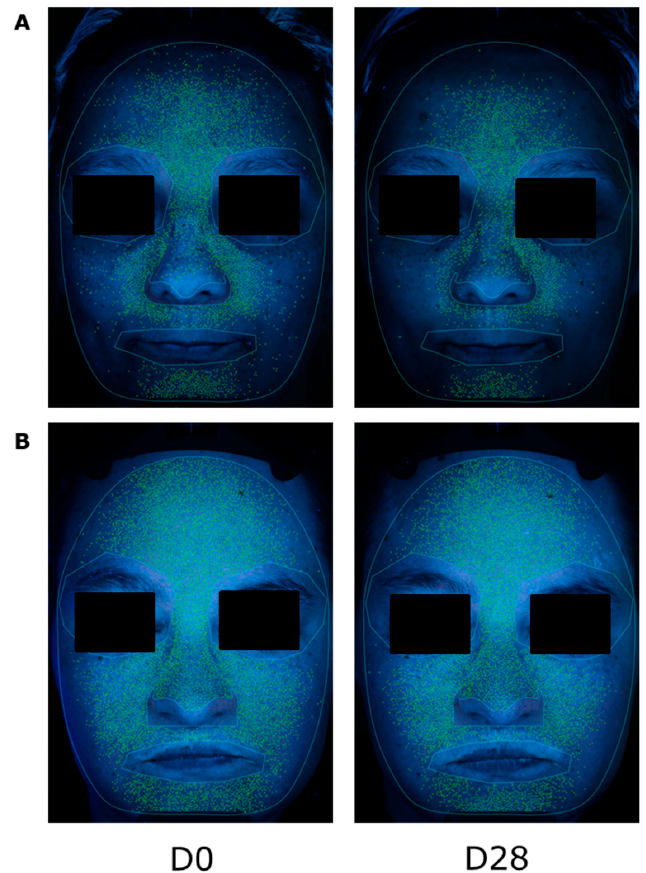
Figure 8. ( A ) Porphyrin detection on volunteer GP027 after application of M. indica at 1%. ( B ) Por- phyrin detection on volunteer GP010 after placebo phyrin detection on volunteer GP010 after placebo application.